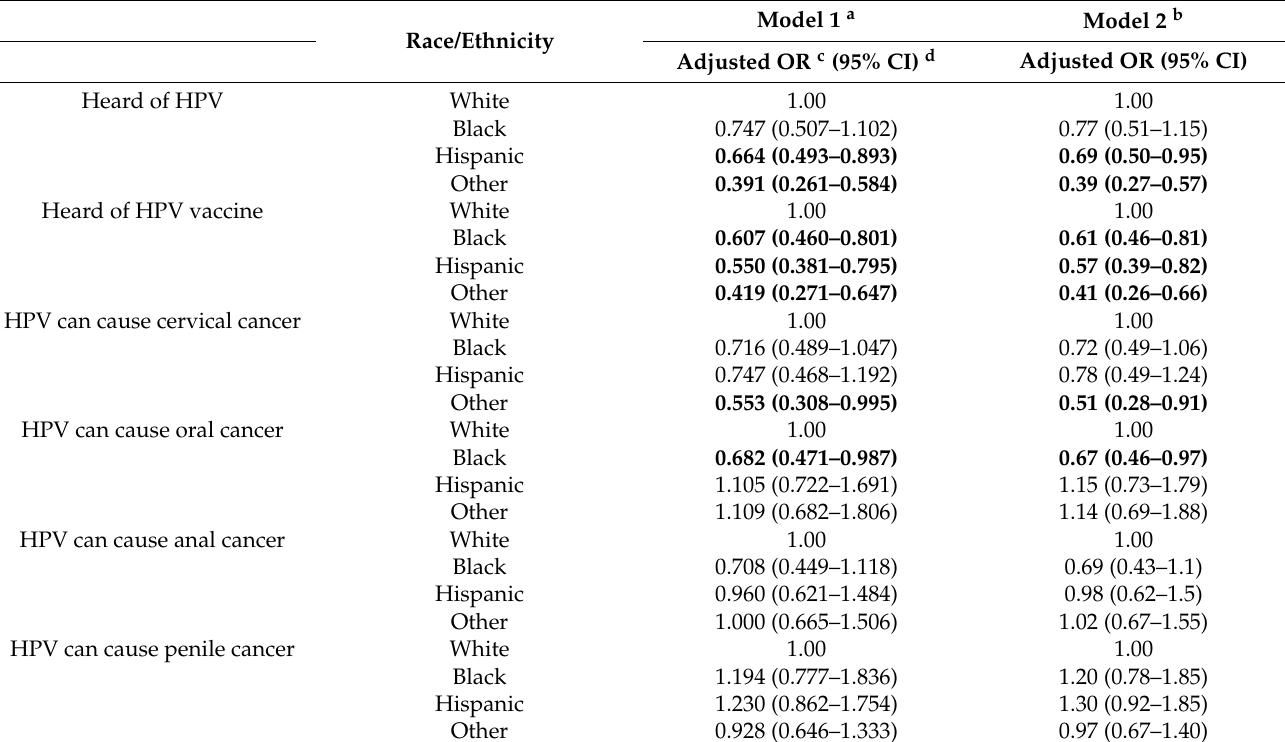
for HCP status. When adjusted for having a regular HCP, Hispanics had 0.69 (95% CI: 0.50–0.95) times the odds of having heard of HPV and 0.57 (95% CI: 0.39–0.82) times the odds of having heard of the HPV vaccine when compared to non-Hispanic Whites. Further, non-Hispanic Blacks had 0.61 (95% CI: 0.46–0.81) times the odds of having heard of the HPV vaccine when compared to non-Hispanic Whites. Additionally, other races/ethnicities had 0.39 (95% CI: 0.27–0.57) times the odds of having heard of HPV and 0.41 (95% CI: 0.26–0.66) times the odds of having heard of the HPV vaccine when compared to non-Hispanic Whites. Weighted multivariate logistic regression analyses examining HPV knowledge and awareness by racial/ethnic